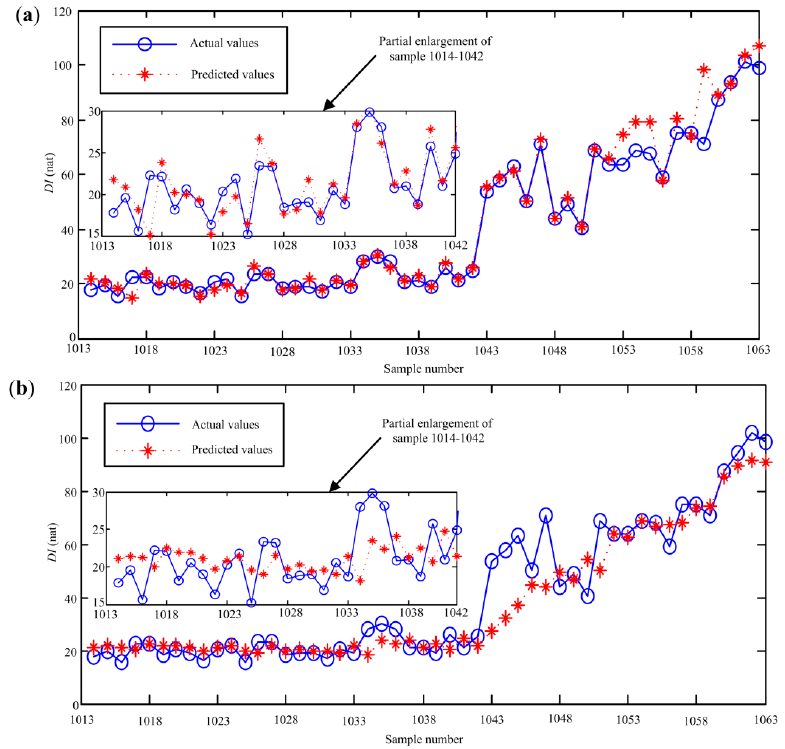
Figure 13. Figure 13. Cont.